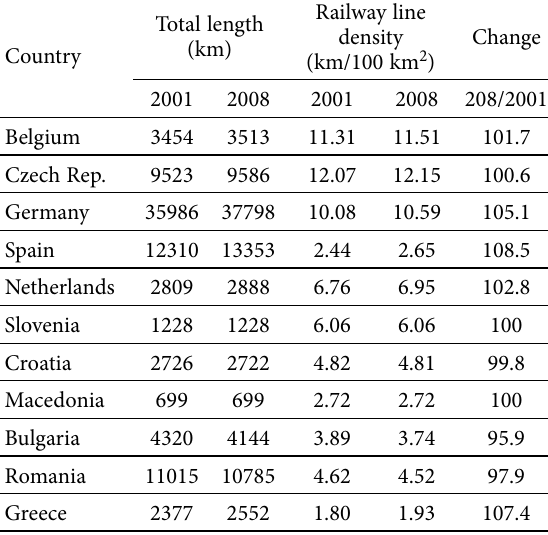
Table 2. Total length of railway lines and rail network density between 2001 and 2008